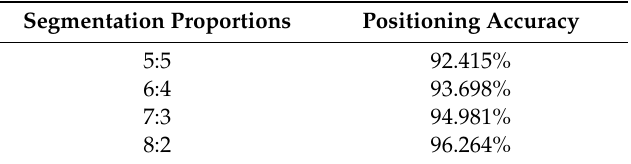
Table 2. Accuracy of the 3D positioning under di ff erent segmentation proportions.